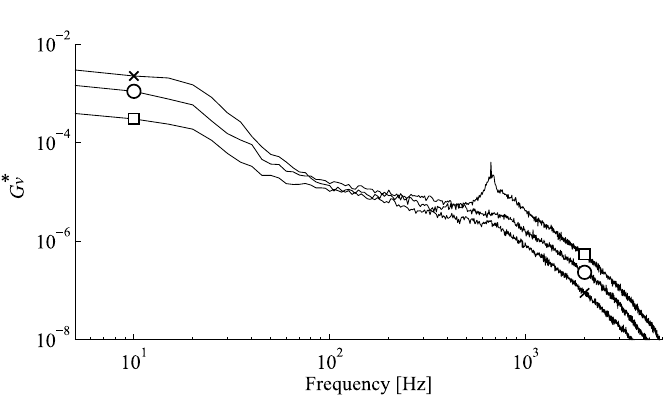
Fig. 6 PSD of transverse velocity v at the vortex center (same symbols notation as Fig.